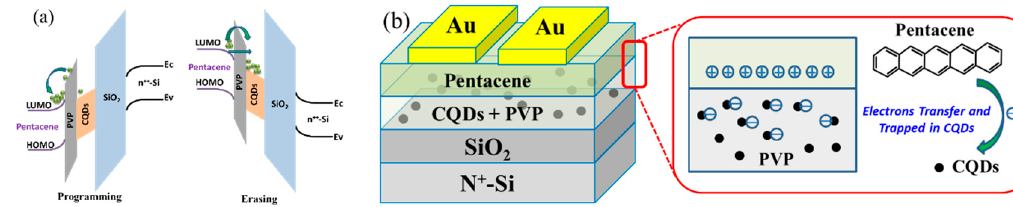
Figure 6. ( a ) Energy band diagrams of devices A and B during programming/erasing (P/E) operation and ( b ) erasing operating mechanism for devices A and B.